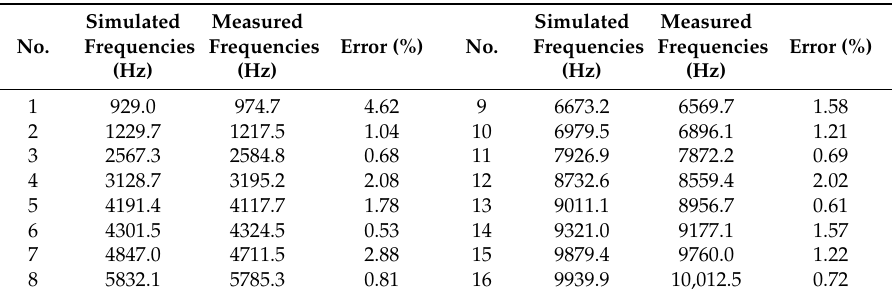
Table 2. Simulated and measured mode frequency of cylinder liner.